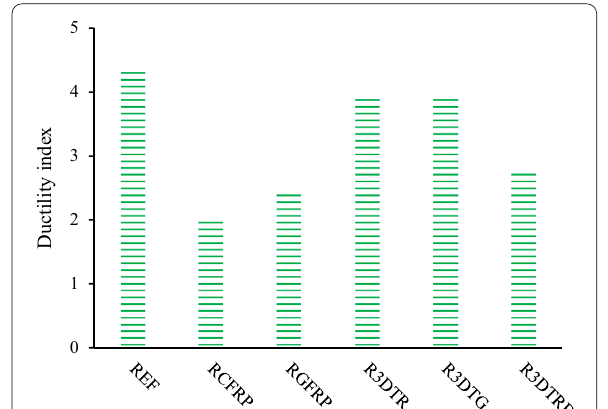
Fig. 19 Ductility indices and energy ratio of all specimens.